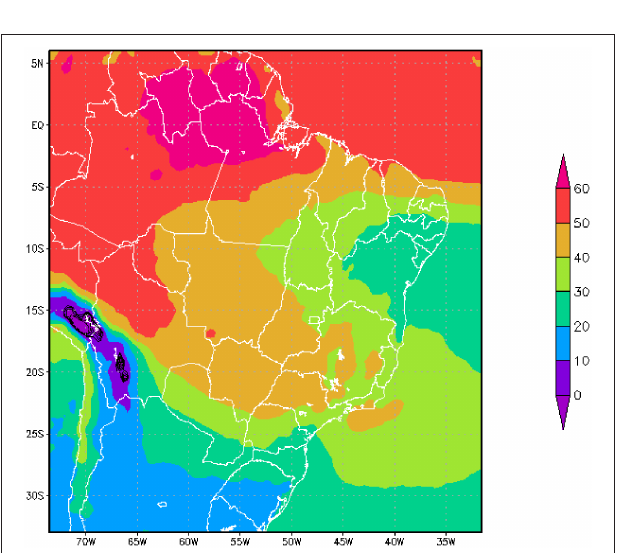
FIGURE 6 | Downward Long Wave Radiation at Surface mean change (W m − 2 ) for the period 2071–2100 relative to the climatological run.